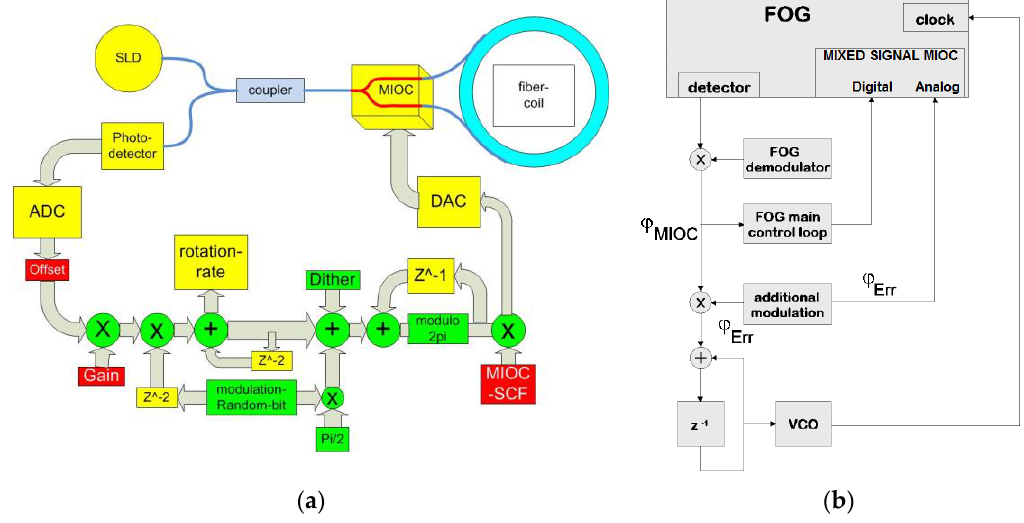
Figure 7. ( a ) Block diagram showing a single-axis closed-loop FOG including signal processing datapath; ( b ) Block diagram showing FOG modulation frequency tracking.